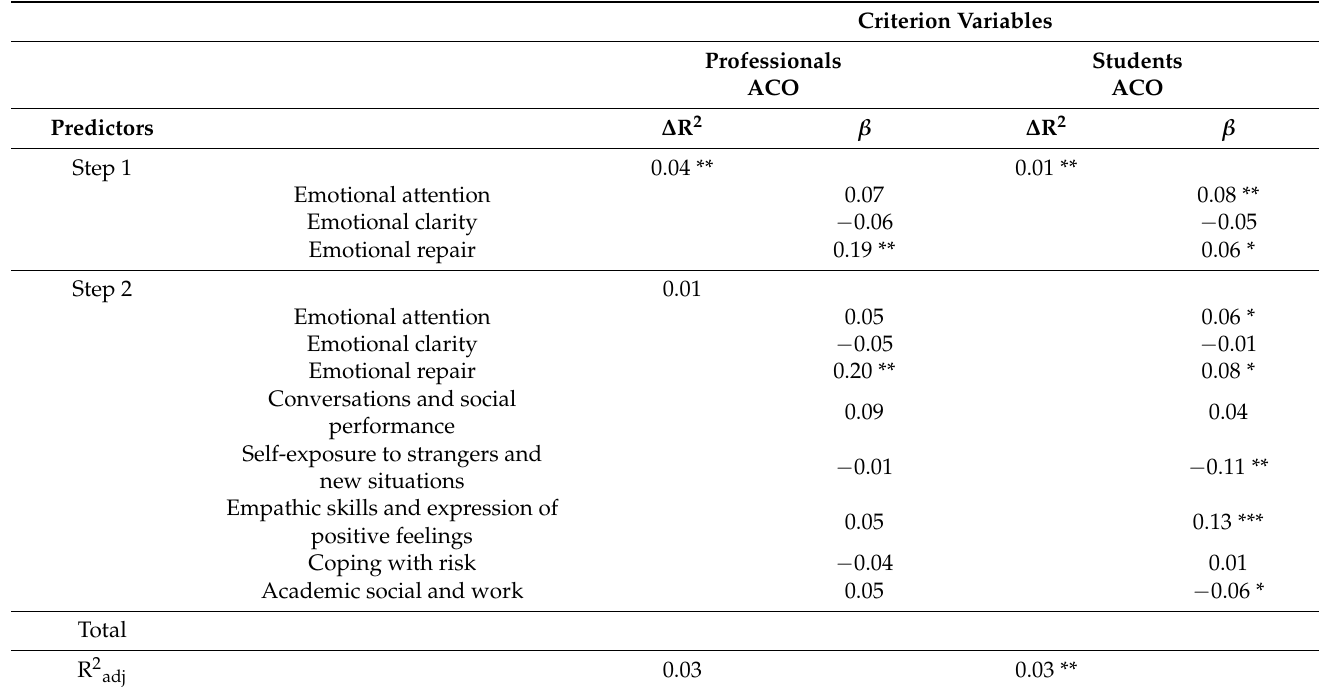
Table 3. Hierarchical regression